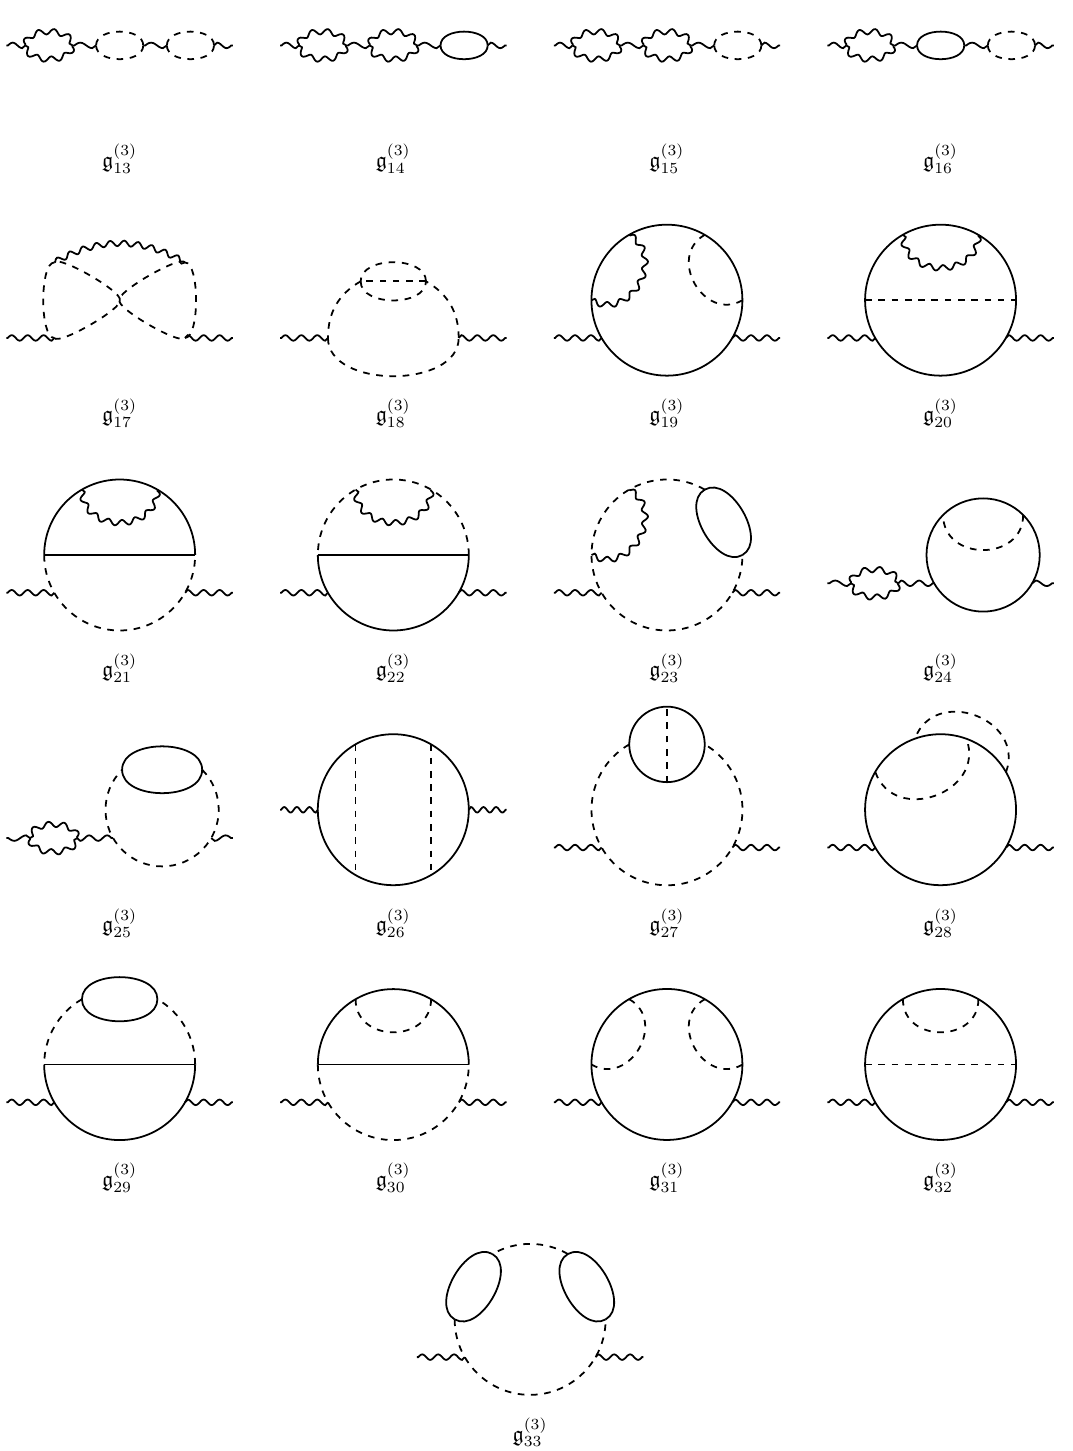
Figure 2 . (Continued) Graph representation of the TSs appearing in the gauge (cid:12) -function, (cid:12) ( ‘ ) at 1- to 3-loop orders.